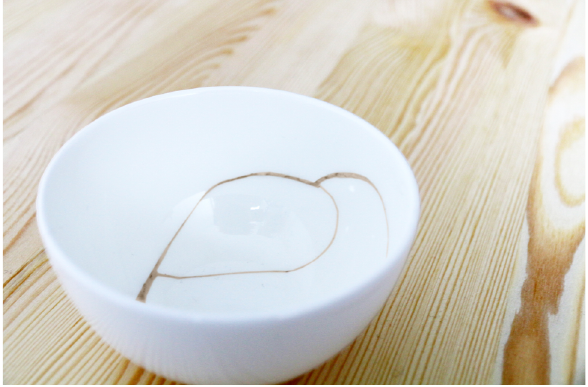
Figure 3 | Photo of “Chrysalis